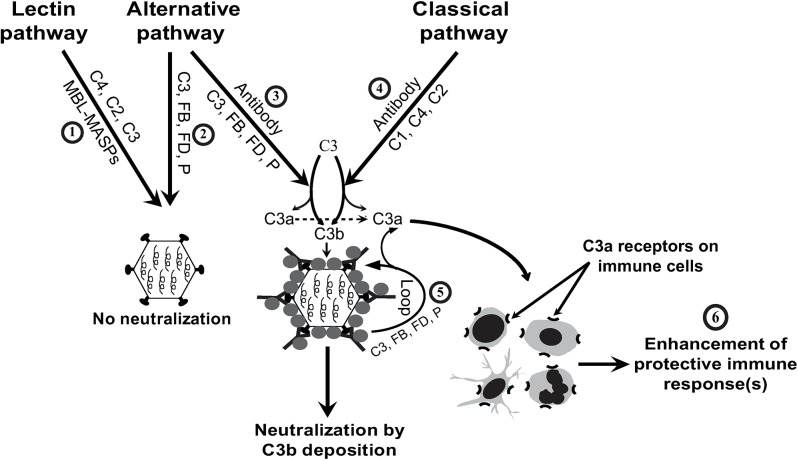
Model for the interplay between CP and AP during A(H1N1)pdm09 virus infection.Synergy between CP and AP is critical to contain the influenza A(H1N1)pdm09 virus infection. 1) The virus is resistant to LP-mediated neutralization (Fig 9F). 2) It is also resistant to AP-mediated neutralization (Figs 8B & 9B). 3) It becomes susceptible to AP-mediated neutralization when coated with virus-specific antibodies (Figs 8C & 9C). 4) It is susceptible to CP-mediated neutralization (Figs 8A & 9A). 5) Augmentation of CP initiated complement activation through activation of AP-loop results in enhanced CP-mediated neutralization (Fig 8D). 6) Complement activation product C3a helps in the enhancement of protective immune responses owing to activation of immune cells (Fig 7).